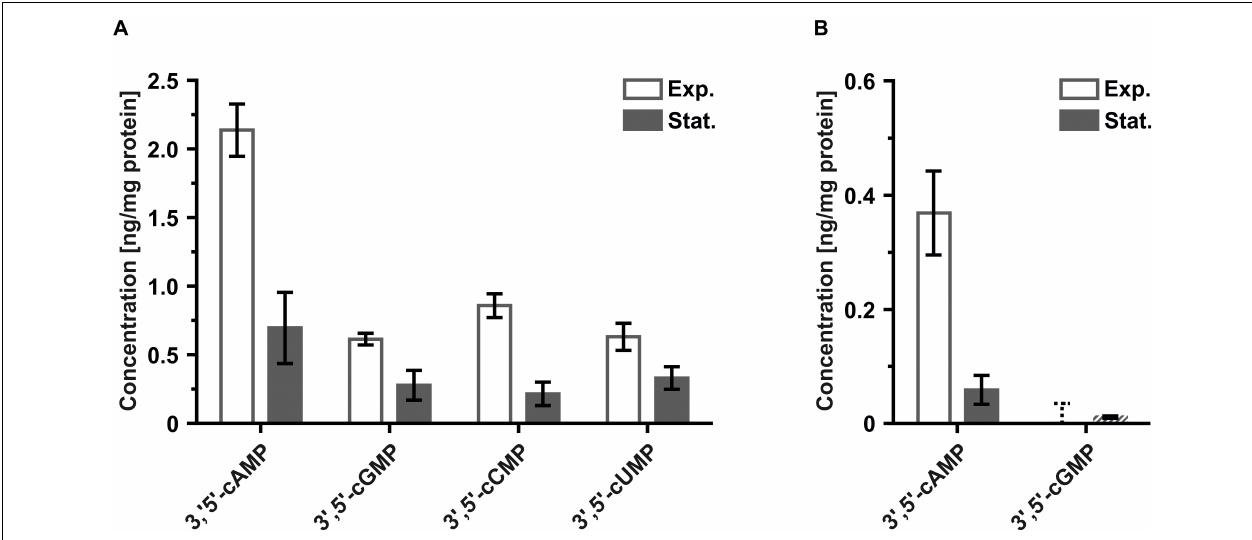
FIGURE 1 | Levels of 3 (cid:48) ,5 (cid:48) -cNMPs detected for exponentially and stationary growing (A) H. volcanii H26 and (B) S. acidocaldarius MW001 cells normalized to the protein content of each sample. Values of regular columns represent the mean of three biological replicates. Error bars of regular columns indicate standard deviation of three biological replicates. Dashed columns indicate the presence of one or more technical replicates with measured nucleotide levels below the lowest limit of quantification (LLOQ). Values of dashed columns represent the mean of all technical replicates with nucleotide levels ≥ LLOQ. Error bars of dashed columns indicate standard deviation of all technical replicates with nucleotide levels ≥ LLOQ. Dashed error bars indicate absence of a single technical replicate with measured nucleotide levels ≥ LLOQ. Values of dashed error bars represent the highest calculated value of all analyzed technical replicates with measured nucleotide levels < LLOQ. The exact nucleotide concentrations are summarized in Table 2 (Exp., exponential; Stat., stationary).